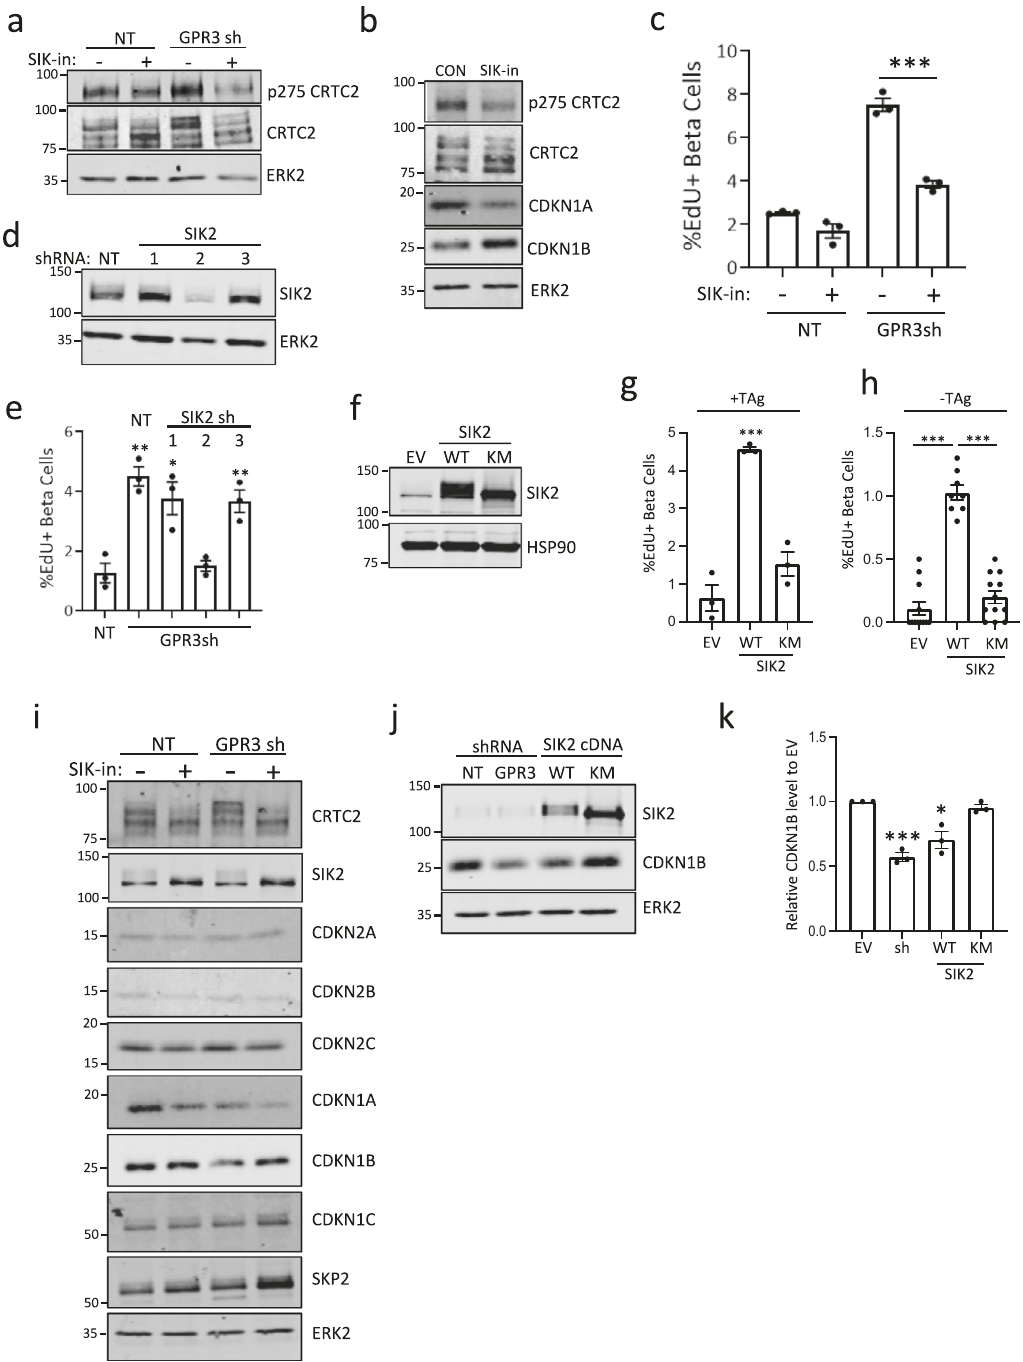
Fig. 4 GPR3 promotes quiescence by inhibiting SIK2. a Western blot showing an increase in the phosphorylation status of SIK2 target protein CRTC2. The effect of pan-SIK inhibitor (SIK-in) is shown. b Western blot showing the effect of SIK-in on levels of CDKN1A and CDKN2B in human islet cells. c Barplot showing the effect of SIK-in on proliferation in GPR3-silenced human β cells. p -value = 0.00047. d Western blots showing silencing of SIK2 with shRNA2. e Effect of co-silencing SIK2 in cells silenced for GPR3 on β cell proliferation. p -values vs NT: GPR3sh = 0.0021, GPR3sh + SIK2sh1 = 0.018, GPR3sh + SIK2sh3 = 0.009. f Western blot showing levels of SIK2 wild type (WT) and kinase-dead (KM mutant) proteins. g , h Barplots showing the effect of overexpression of SIK2 WT and kinase-dead (KM) mutants of SIK2 on β cell proliferation in the presence and absence of TAg. EV vs. KM = not signi fi cant. The p -value for g = 0.00042. p -values for ( h ) are 3.35 × 10 − 9 and 1.35 × 10 − 8 . i Western blots showing levels of CIP/KIP proteins in GPR3 silenced β cells. Effect of pan-SIK inhibitor HG-9-91-01 (SIK-in) shown. j Western blots showing CDKN1B levels in cells following GPR3 silencing or overexpression of SIK2 WT or kinase-dead mutant (KM). k Barplot showing quanti fi cation of CDKN1B levels. p -values are 0.0002 and 0.0103. Error bars are de fi ned as the standard error of the mean of three biological replicates. All western blots are representative blots from three donors. For ( c ), ( e ), ( g ), and ( h ), the error bars are representative of three donors and are de fi ned as the standard error of the mean of three technical replicates. MWs for Western blot markers are in